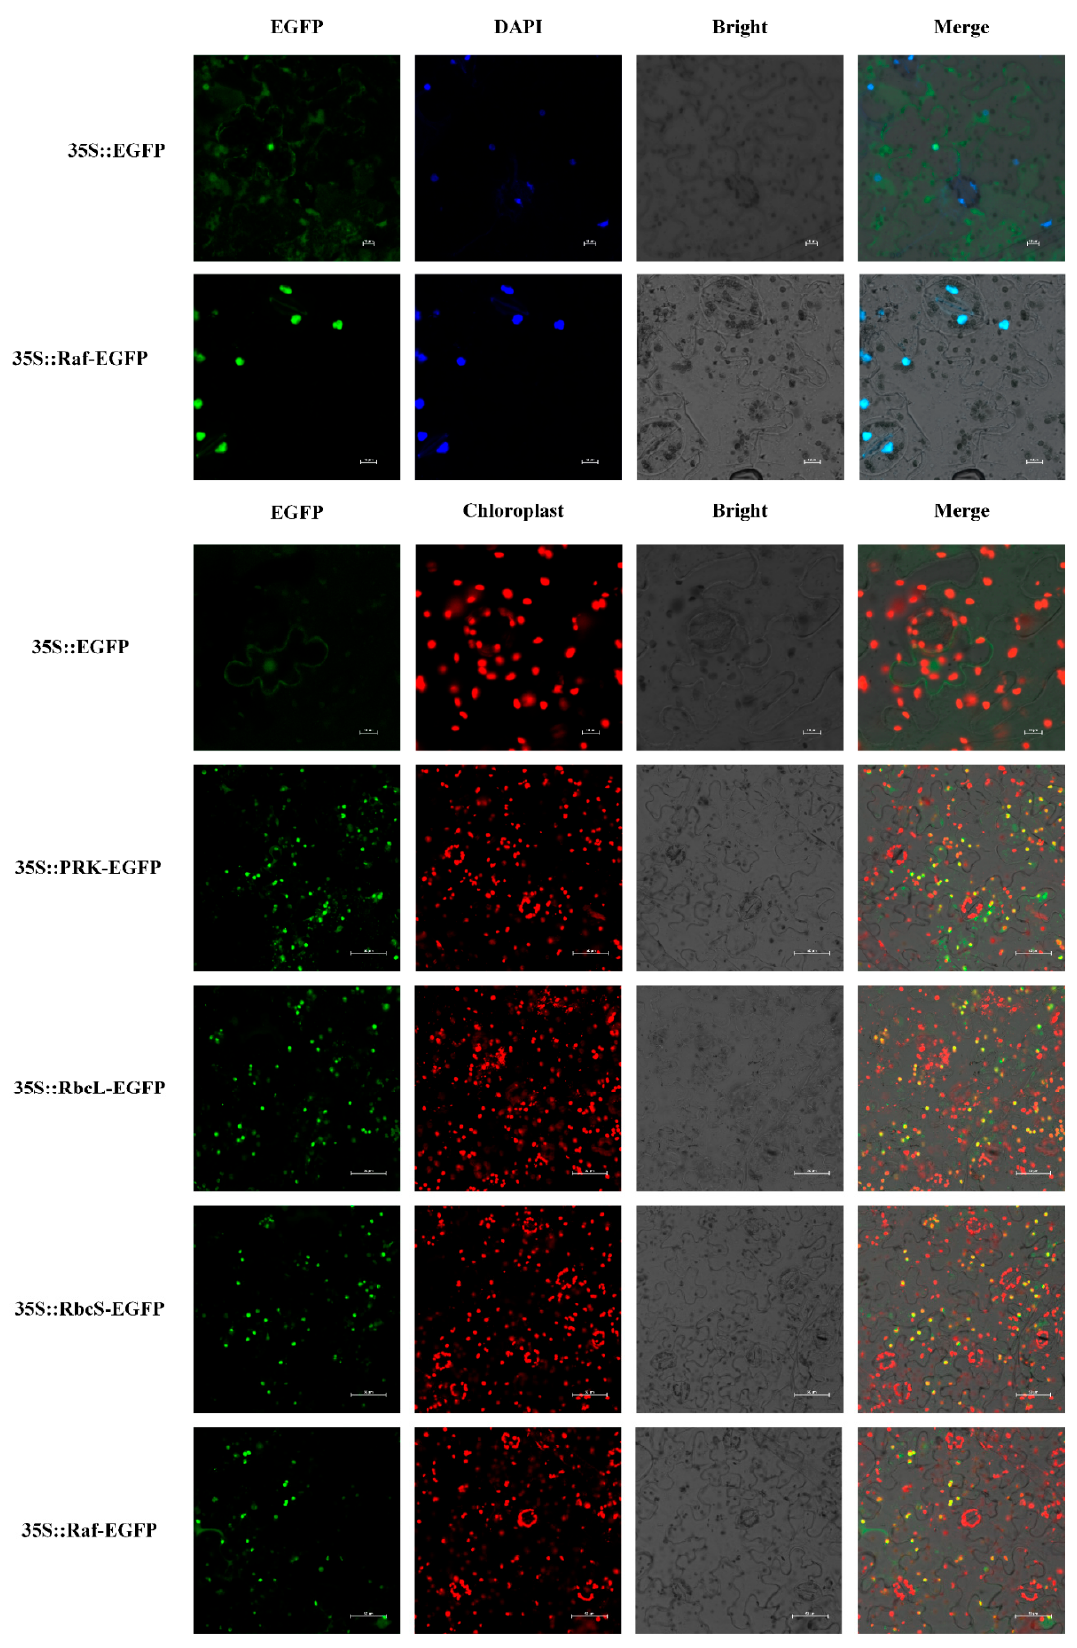
Figure 4. Subcellular localization of DfRbcS, DfRbcL, DfRCA, DfRaf and DfPRK proteins in tobacco leaf cells. The red fluorescence of DAPI indicates the nucleus; bar = 10 μ m.